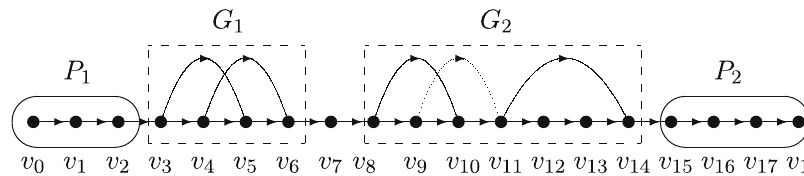
Figure 4: An example for Lemma 2.3.